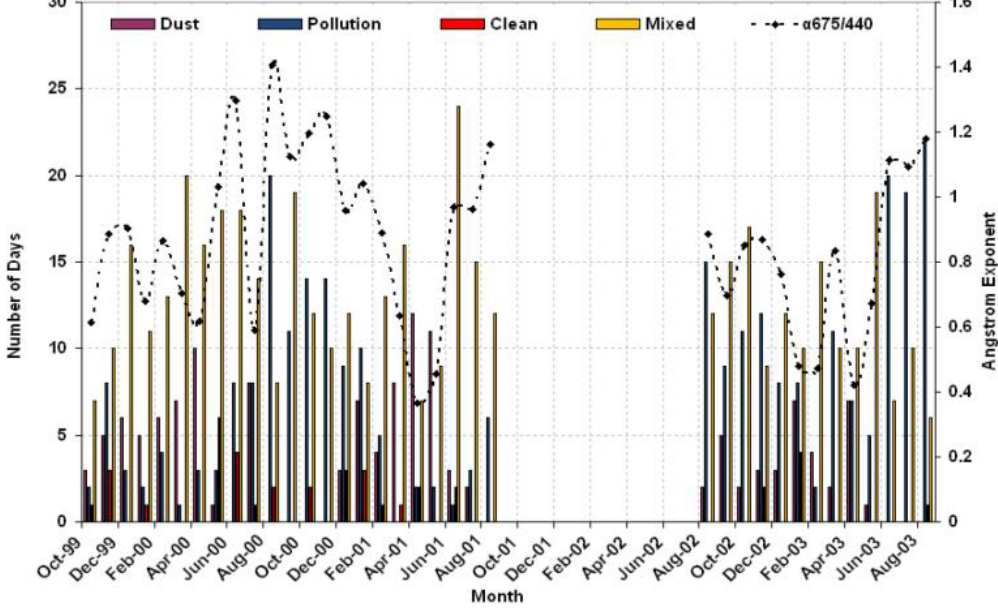
Fig. 1. Number of days with measurements and occurrences for different aerosol categories and their corresponding ˚Angstr¨om exponent over Alexandria for two time periods from October 1999 to August 2001 and from August 2002 to August